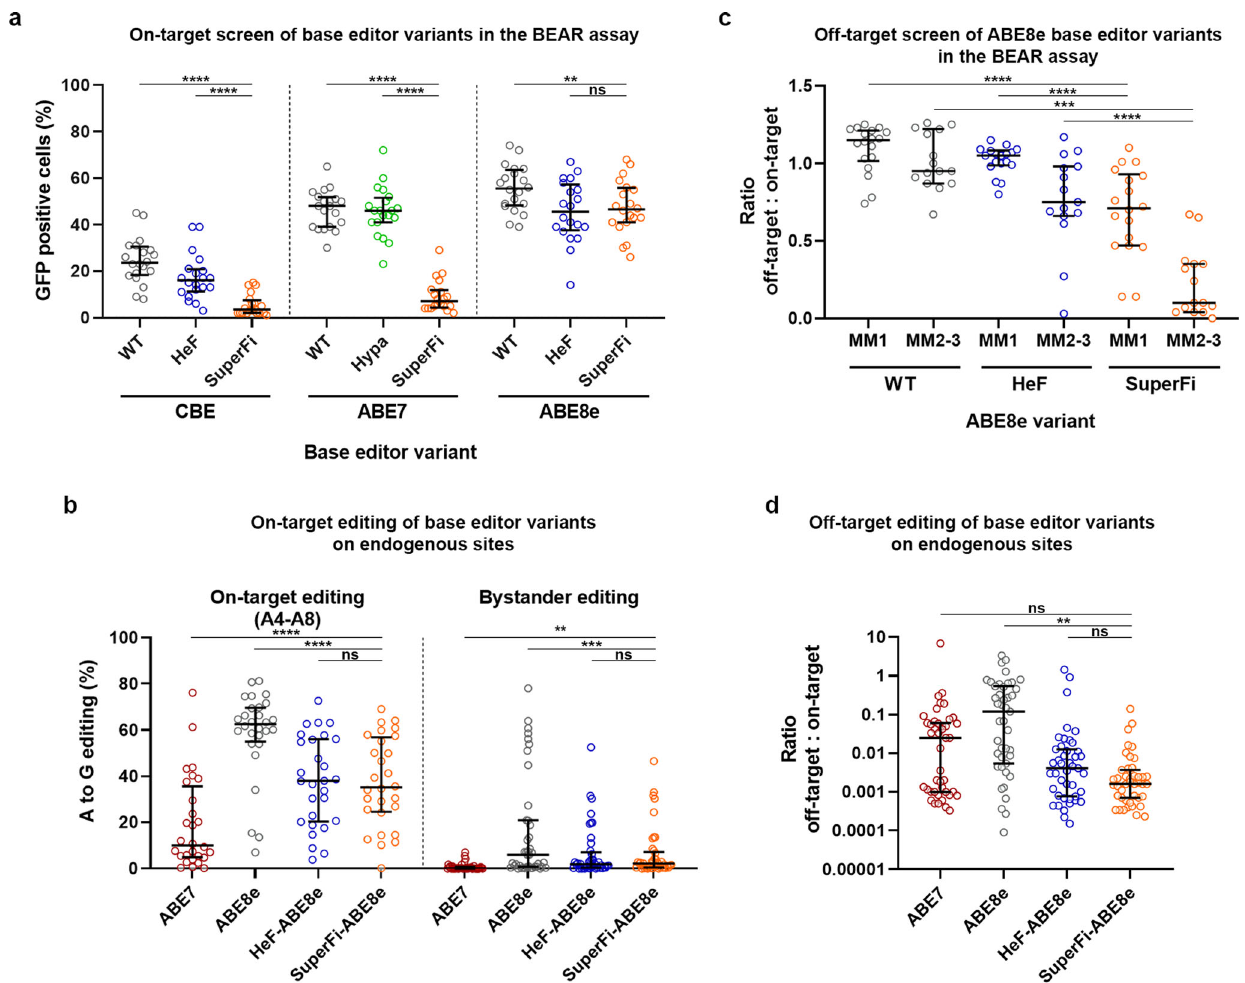
Fig.3|On-andoff-targetactivitiesofSuperFibaseeditorsinmammaliancells. a , c Base editing activities of CBE, ABE7, and ABE8e variants were assessed in the BEAR assay with a 20 matching and c 33 mismatching sgRNAs. The same data are shown by individual targets in Supplementary Figs. 7a and 9a, respectively. b , d Base editing activitiesofABE8evariants on endogenous b on-target and d off- targetsitesasmeasuredbyNGS.DataarealsopresentedinSupplementaryFigs.7b and 9b, respectively. b The editing ef fi ciency (16 genomic sites) of adenines inside (A4-A8, n =28)and outsidethe editing window (bystander editing, n =41) is shown sidebyside,separatedwithadashedline.Regardingbaseediting,thenumberingof the editpositions followsthe convention laidin theliterature, i.e., 5 ’ to 3 ’ direction in the non-targeted strand of the target DNA. c The fi delity of ABE8e variants was assessedintheBEARassaywith2matchingsgRNAsand33sgRNAsmismatchingin